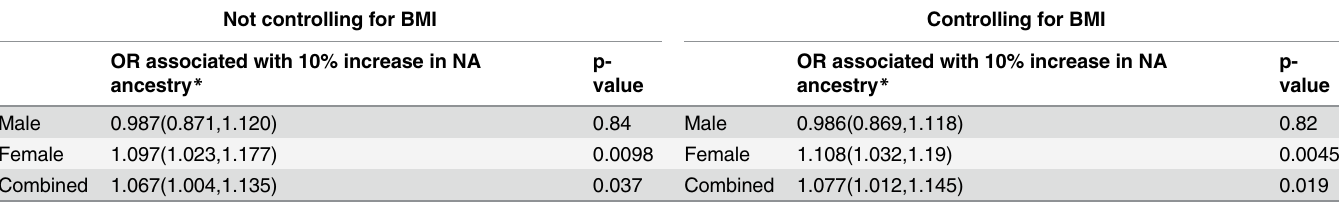
Table 4. Regression analysis of diabetes status with Native American genetic ancestry. Not controlling for BMI